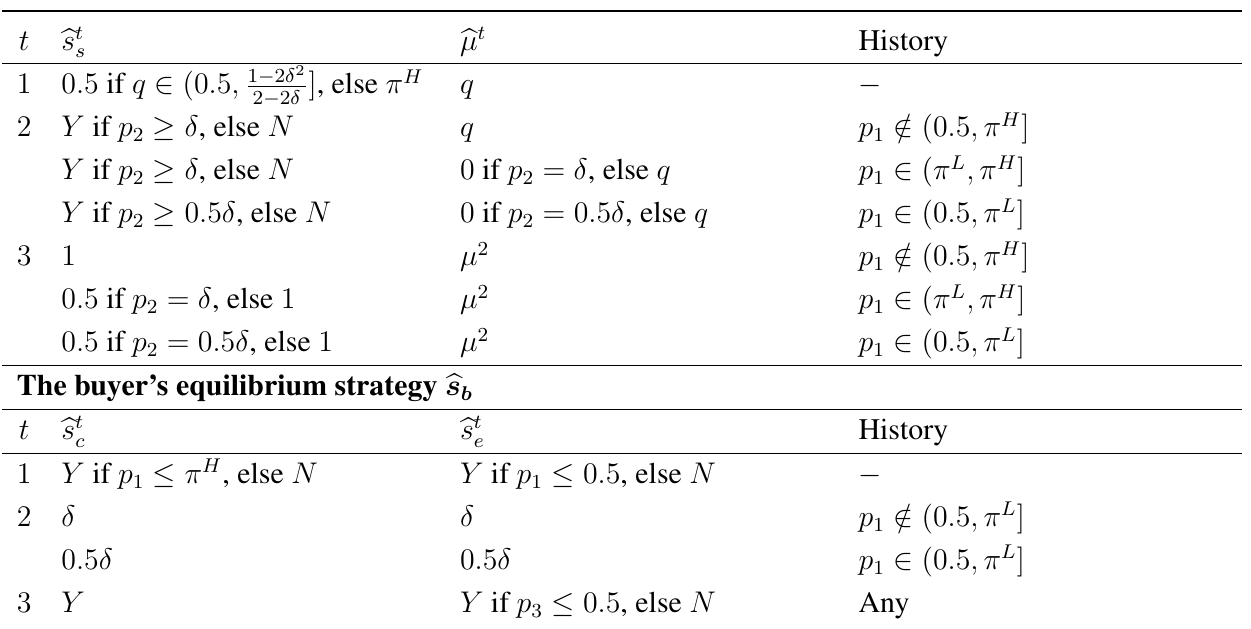
] and δ ≤ 0 . 5 2 − 2 δ